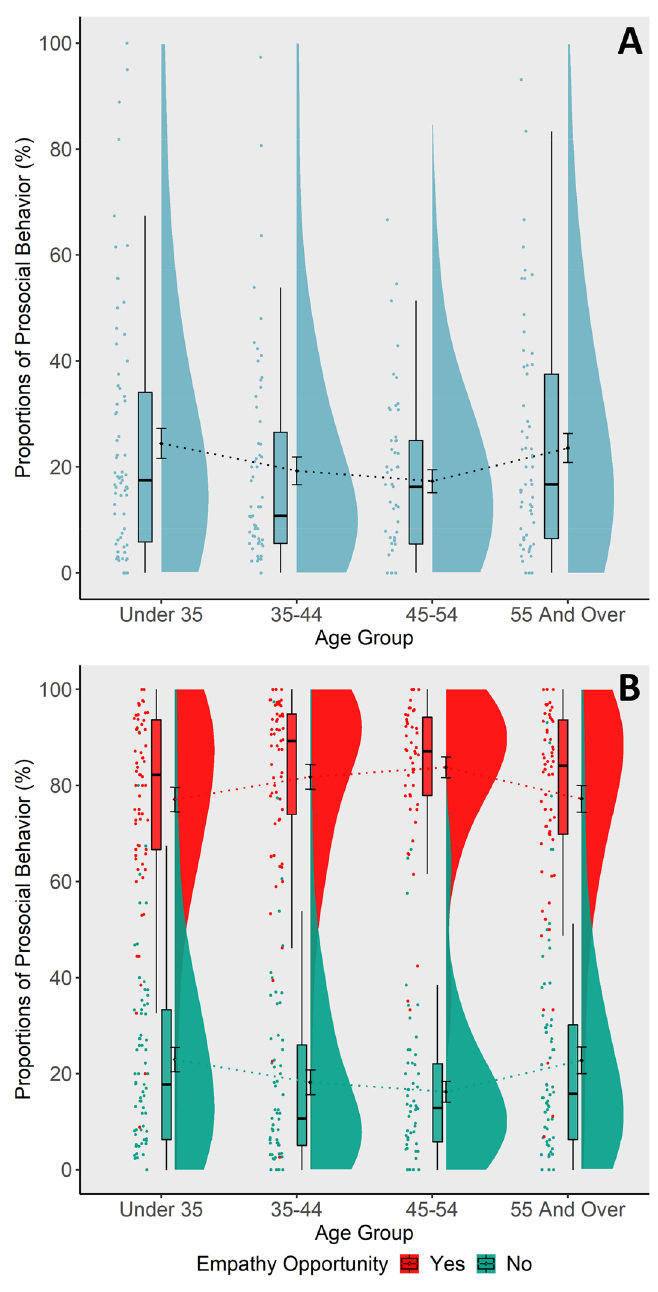
Figure 3. Daily prosocial behavior. The y-axis shows the proportions of answering ‘yes’ when asked about acting prosocially relative to the total amount of answered surveys. ( A ) Adult age differences in prosocial behavior. No significant association between age and prosocial behavior was found. ( B ) Within-subject effect of empathy opportunity x age on prosocial behavior. All age groups showed more prosocial behavior after an empathy opportunity. A quadratic effect of age group indicated that this effect was more pronounced in the middle-aged groups than in the younger and older age